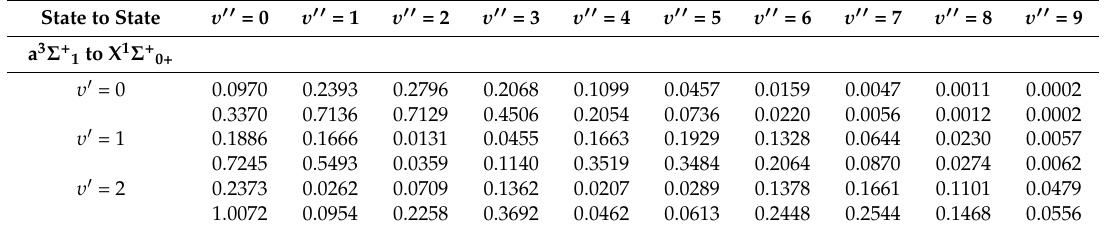
Table 3. FC factors (1st line) and Einstein coefficients (s − 1 , 2nd line) for the a 3 Σ + 1 to X 1 Σ + 0+ transition.